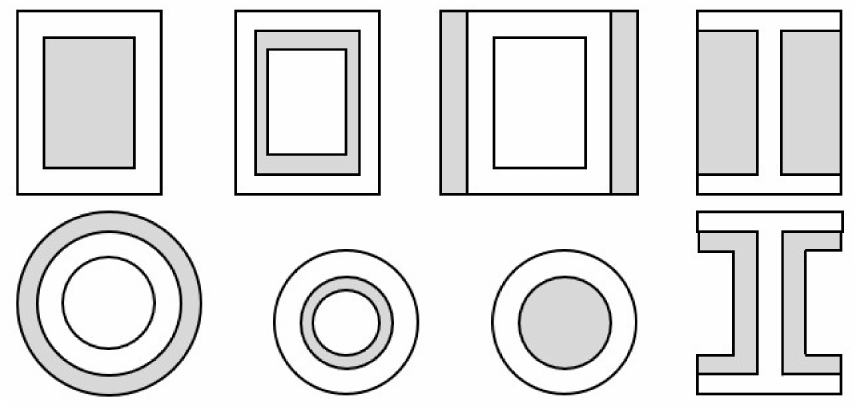
Figure 1. The possible cross-sections of composite VE rods; the grey area is VE.